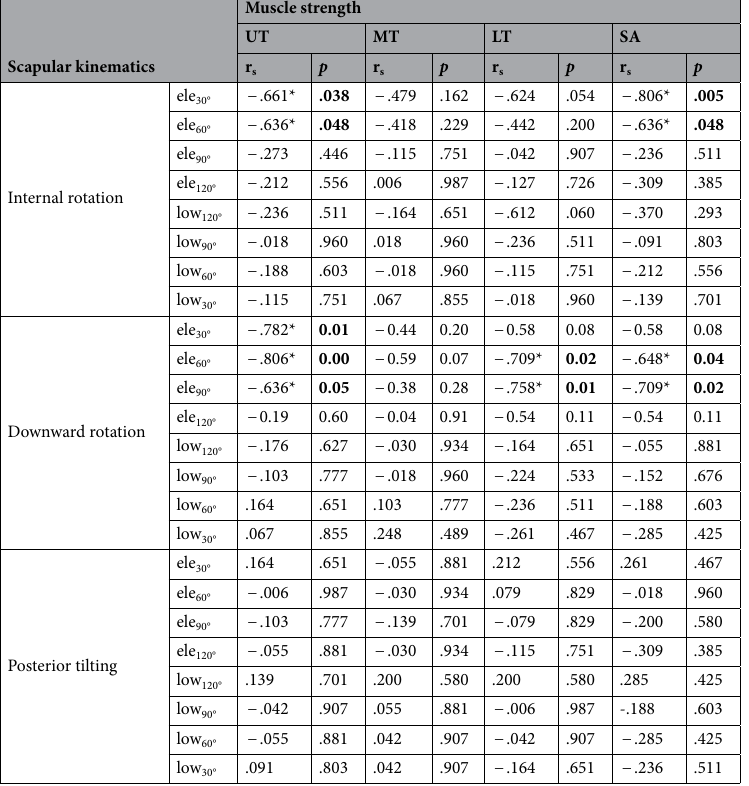
Table 3. The relationship between the maximal strength of periscapular muscles and the scapular kinematics during scaption. *Significant correlation between the maximal strength of periscapular muscles and the scapular kinematics ( p < 0.05). P values set in bold indicate statistical